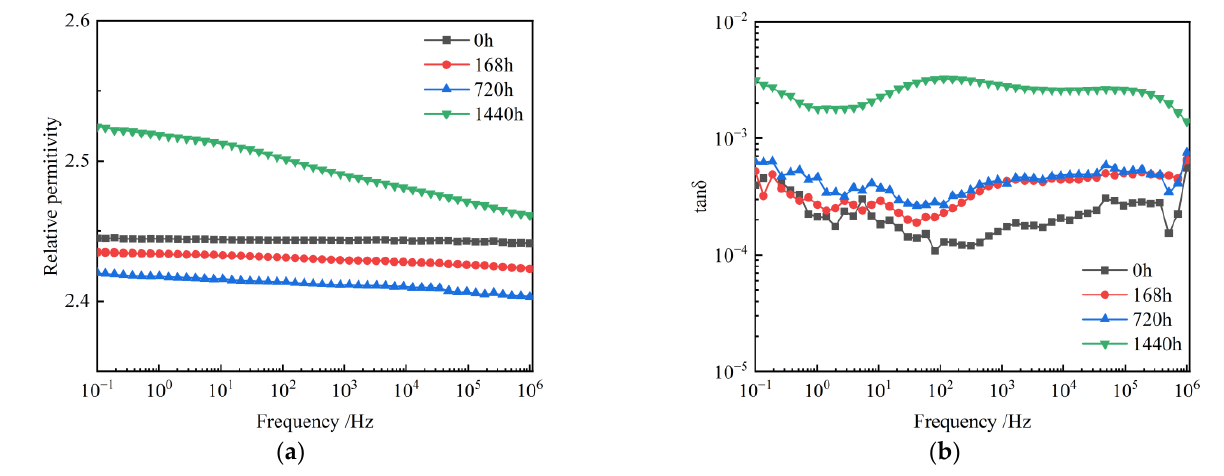
Figure 5. Variation of dielectric properties of the insulation layer under different aging time. ( a ) Relative permittivity; ( b ) dielectric loss.